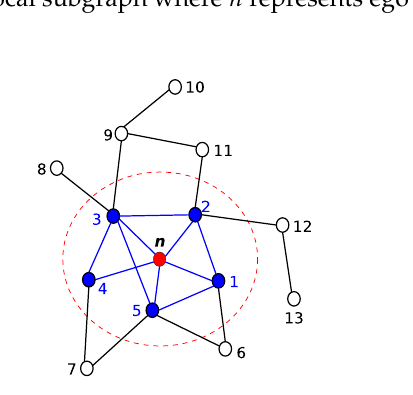
Figure 1. An illustration of the ego-network (local subgraph), where n represents the ego and the nodes (1, 2, 3, 4 and 5) denote the